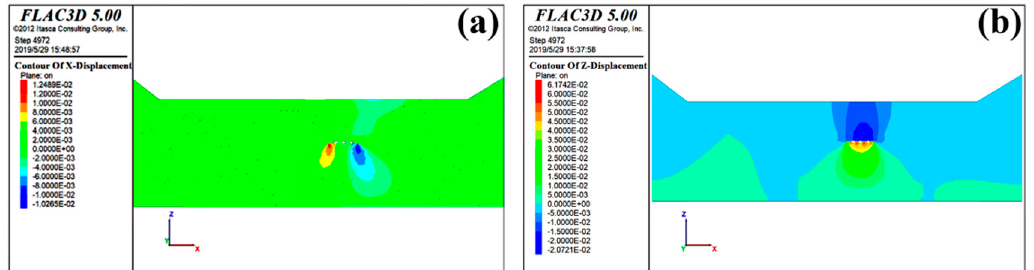
Figure 7. The overall displacements distributions in the horizontal ( a ) and vertical ( b ) directions.